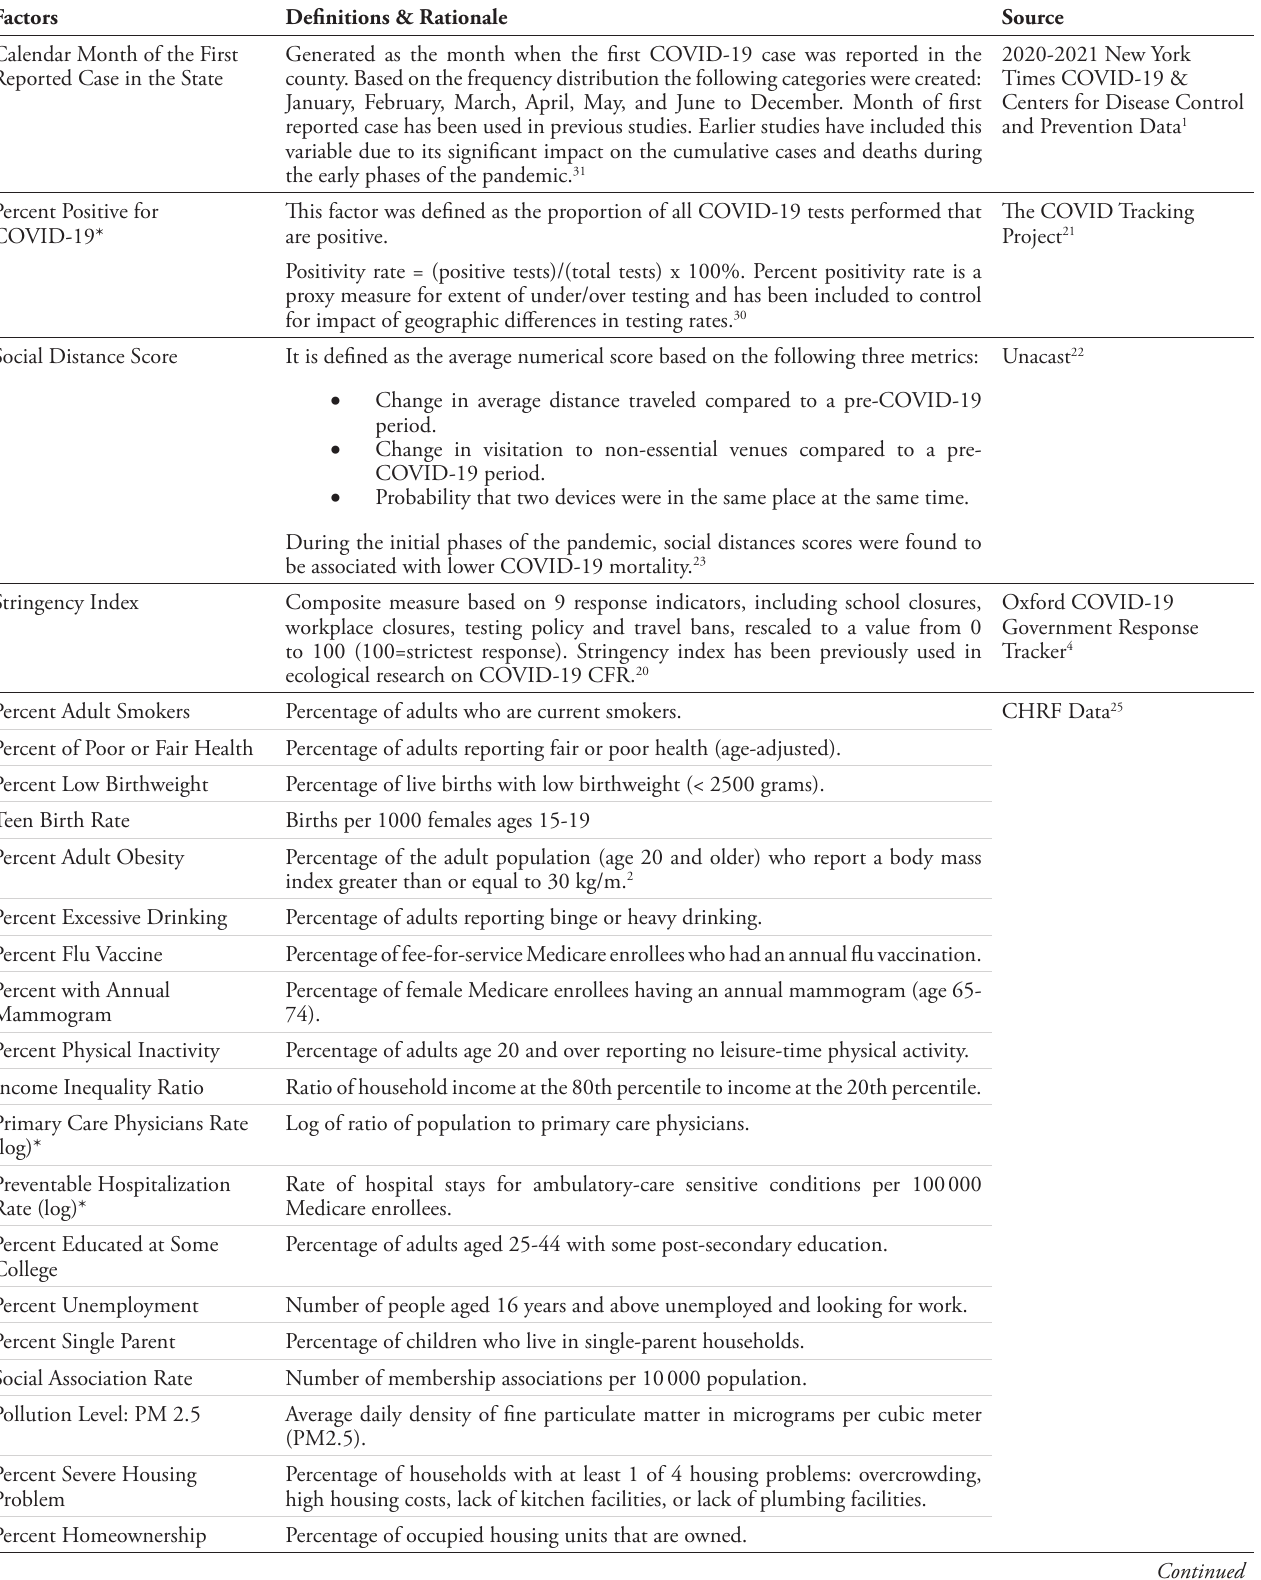
Table 1: Ecological Factors Used in the Analysis: Source Definitions and Modifications Factors Definitions &